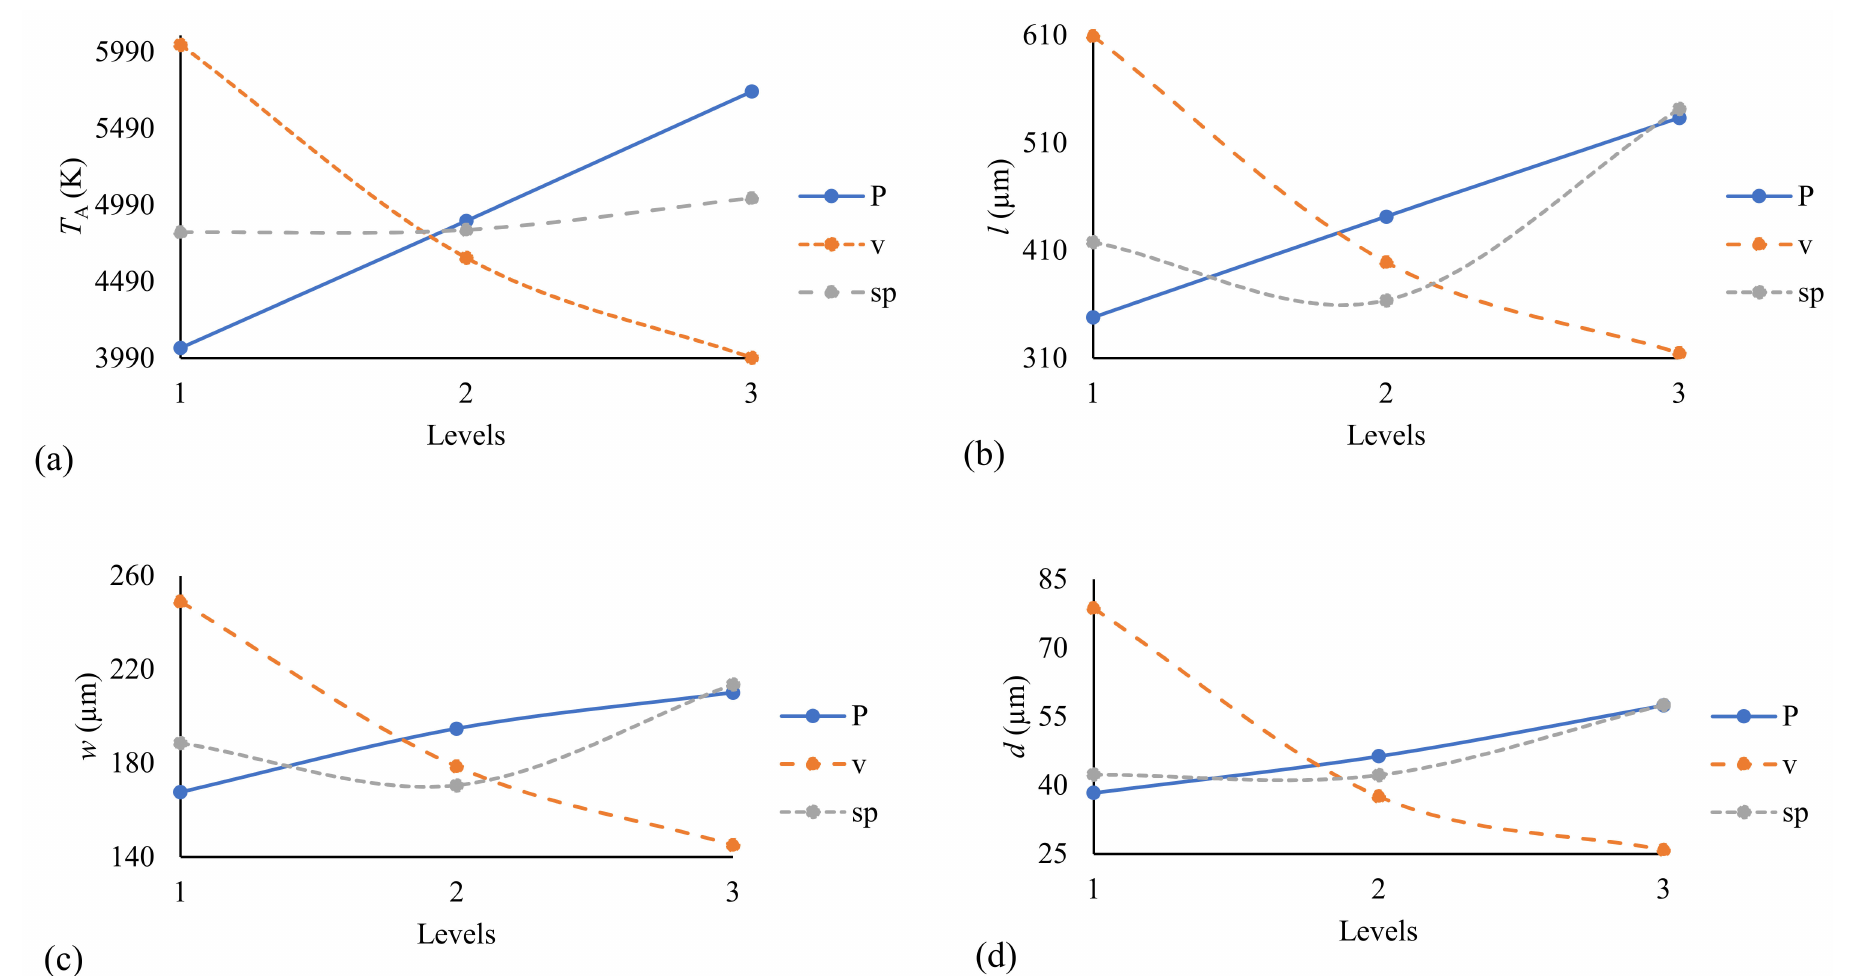
Figure 10. Variation of ( a ) maximum temperature at A ( T A ), ( b ) length of melt pool ( l ), ( c ) width of melt pool ( w ), ( d ) depth of melt pool ( d ) with process